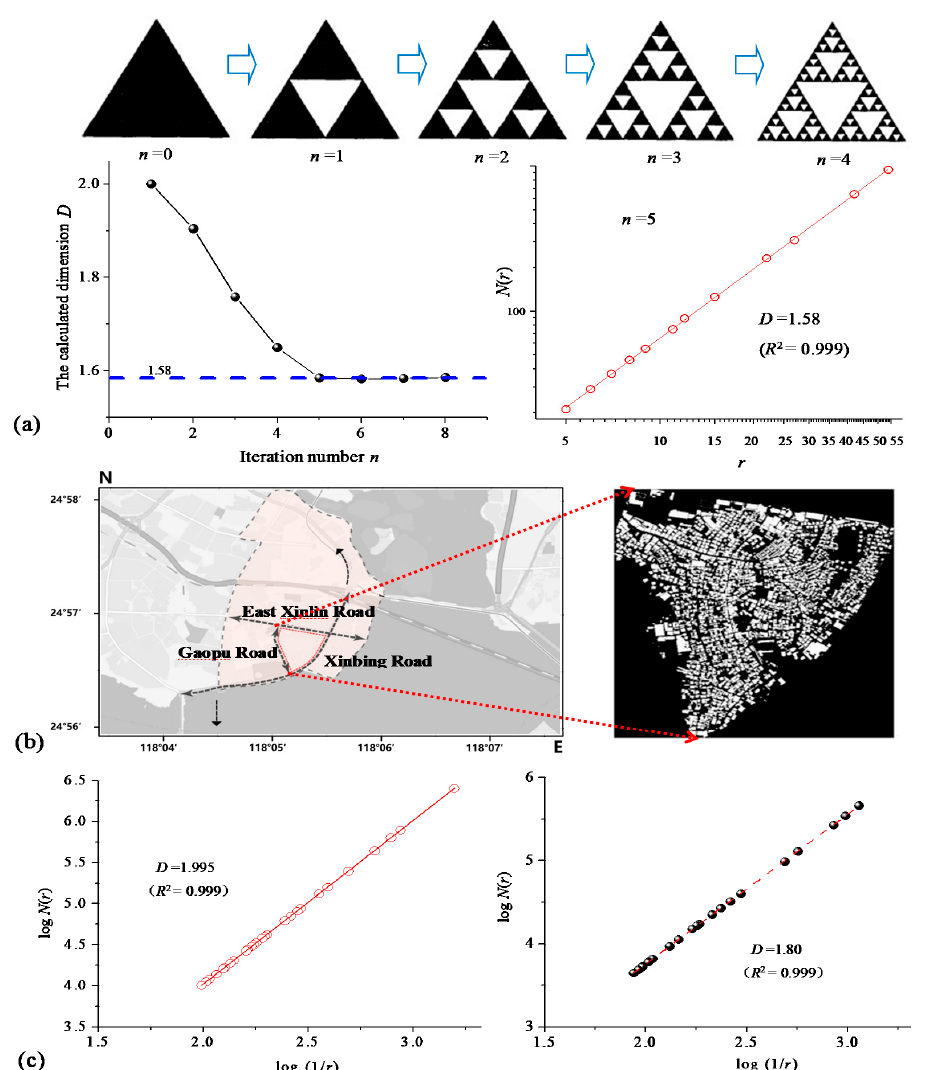
Figure 1. ( a ) Sierpinski triangle evolves with with the iteration number n and the corresponding fractal dimension calculation; ( b ) roads and land-use map of Gaopu settlement; ( c ) the corresponding fractal dimensions of the street blocks and land use of Gaopu settlement.